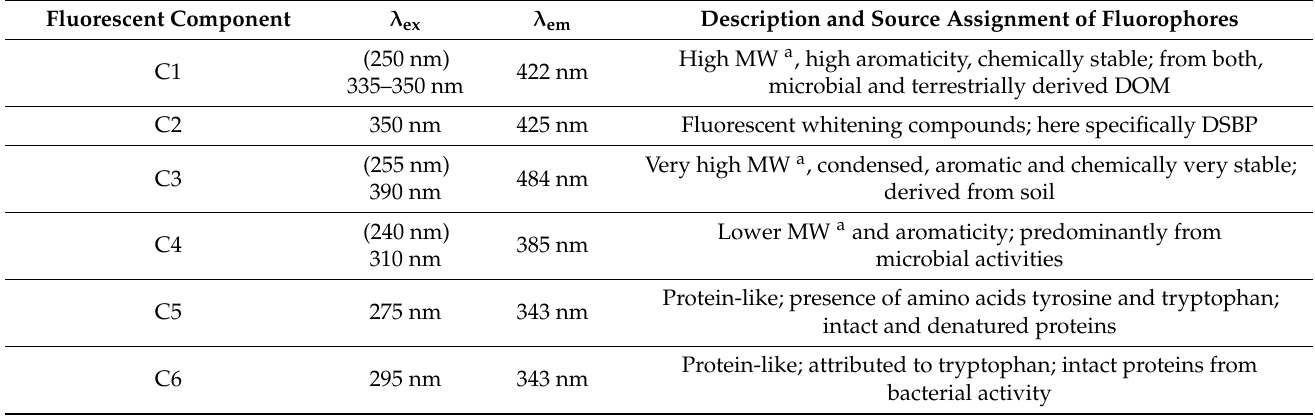
Table 1. Summary of fluorescence excitation–emission maxima ( λ ex / λ em ) and source assignment of fluorophores for each component obtained from the PARAFAC analysis. Fluorescent